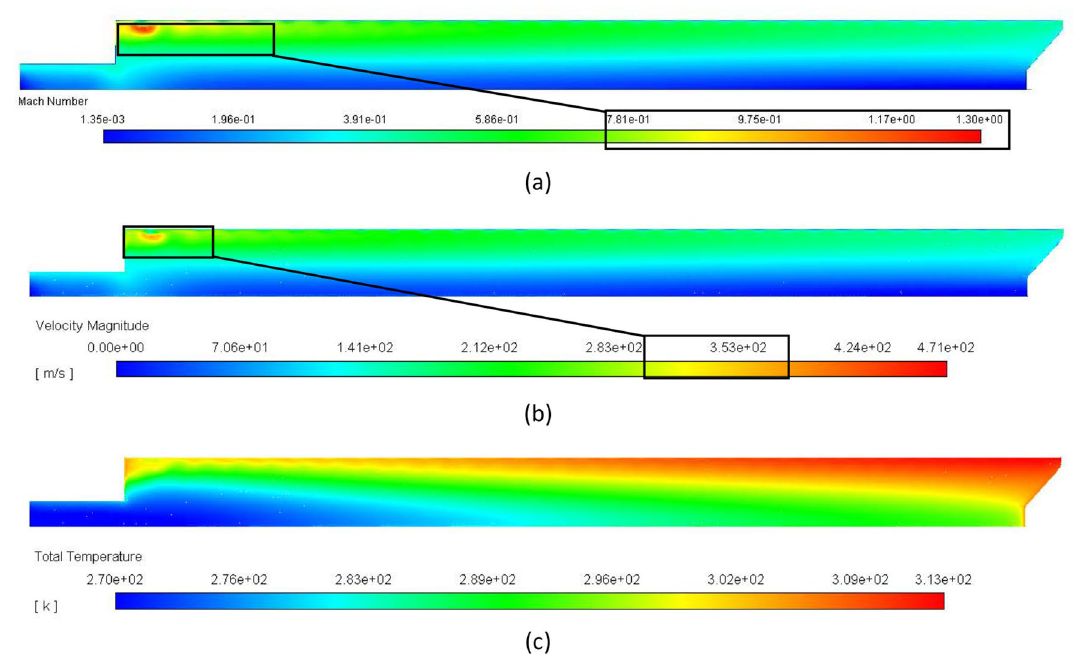
Fig. 5 Contour plots at the period surface for air a Mach number contour, b velocity magnitude, c total Temperature